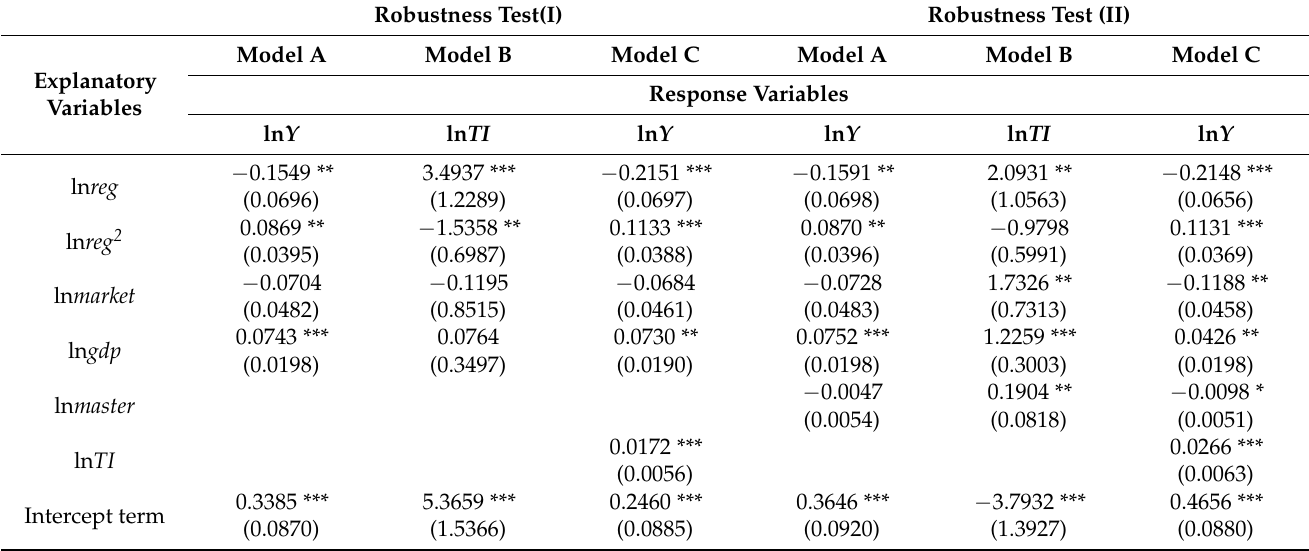
Table 6. Robustness